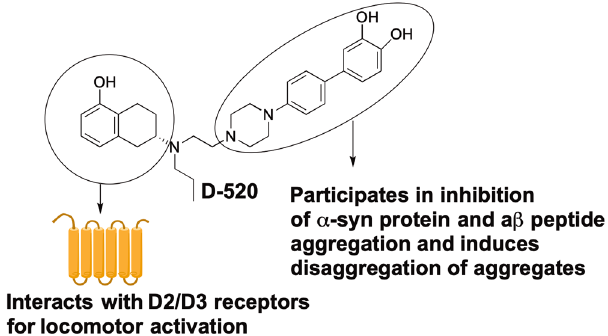
Figure 1. Mode of action for multifunctional activity of